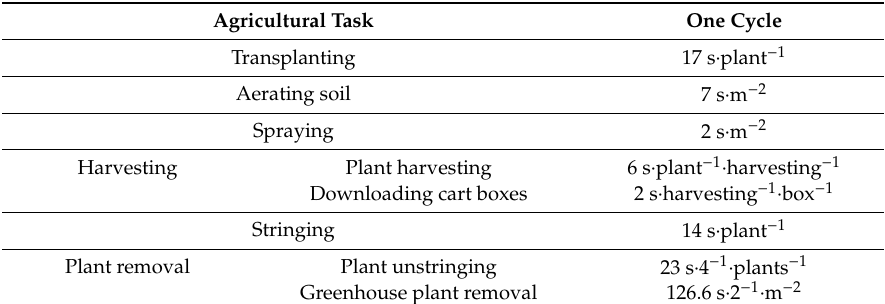
Table 8. Time in seconds of one cycle for each agricultural task.